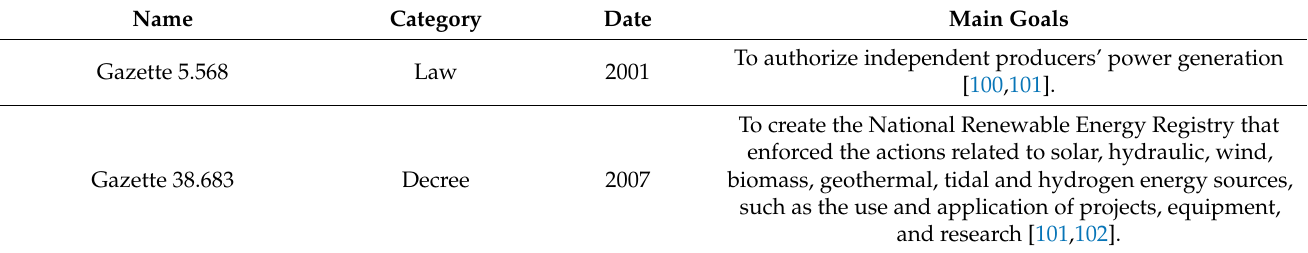
Table 6. Main government incentives for the entry of renewable energy into Venezuela’s electricity